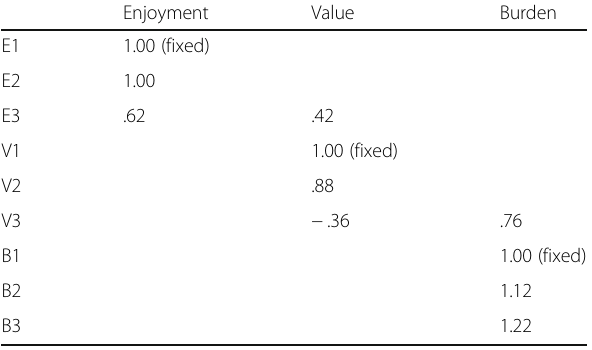
Table 1 Factor loadings survey attitude scale (unstandardized)